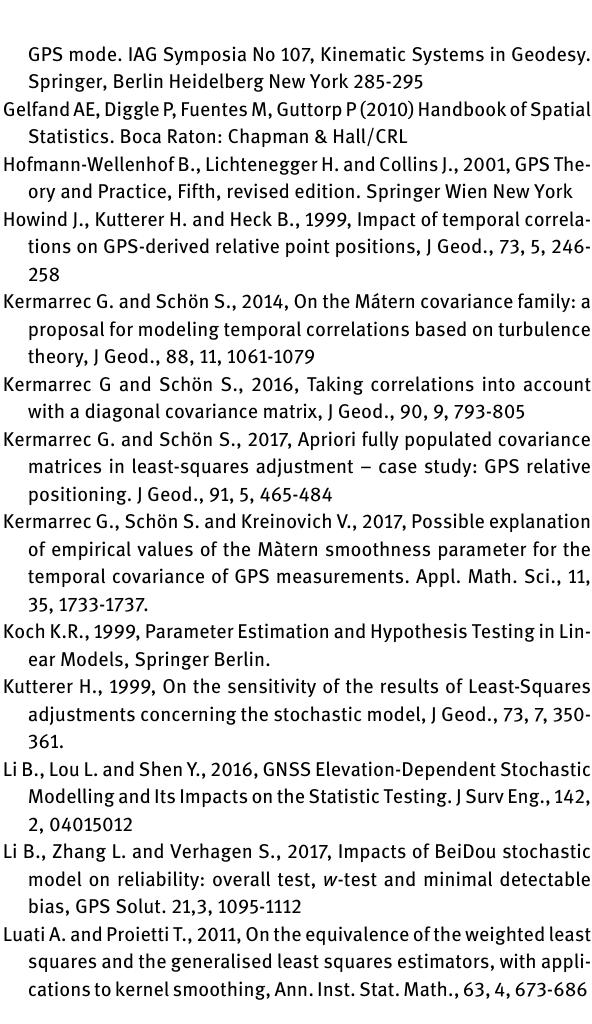
Figure 1: Results of the Monte Carlo simulations study with 10000 iterations per Mátern parameters set. Simulated observations are correlated with [ α , v ] 0 = [0.01, 1] (blue point), the Mátern parame- ters of the estimated VCM are varied. The mean value of the ratio R is